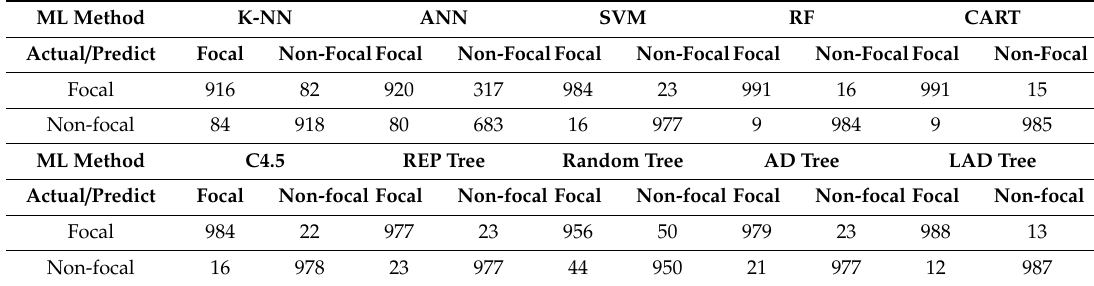
Table A6. Confusion matrix for